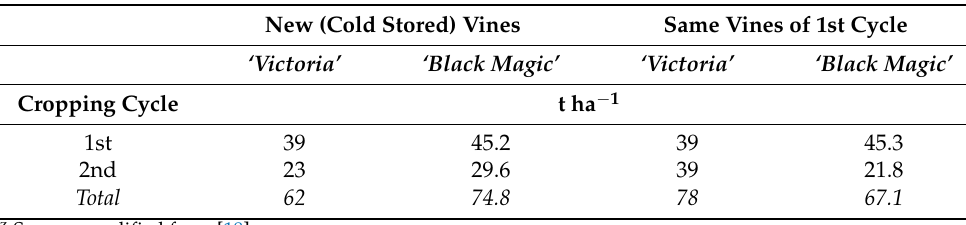
Table 4. Vine yield (t ha − 1 ) during two consecutive cropping cycles in ‘Black Magic’ and ‘Victoria’ table-grape soil-less cultivation at a theoretical plant density of 15,600 plants ha − 1 , submitted to double-cropping system z . New (Cold Stored) Vines Same Vines of 1st Cycle ‘Victoria’ ‘Black Magic’ ‘Victoria’ ‘Black Magic’ Cropping Cycle